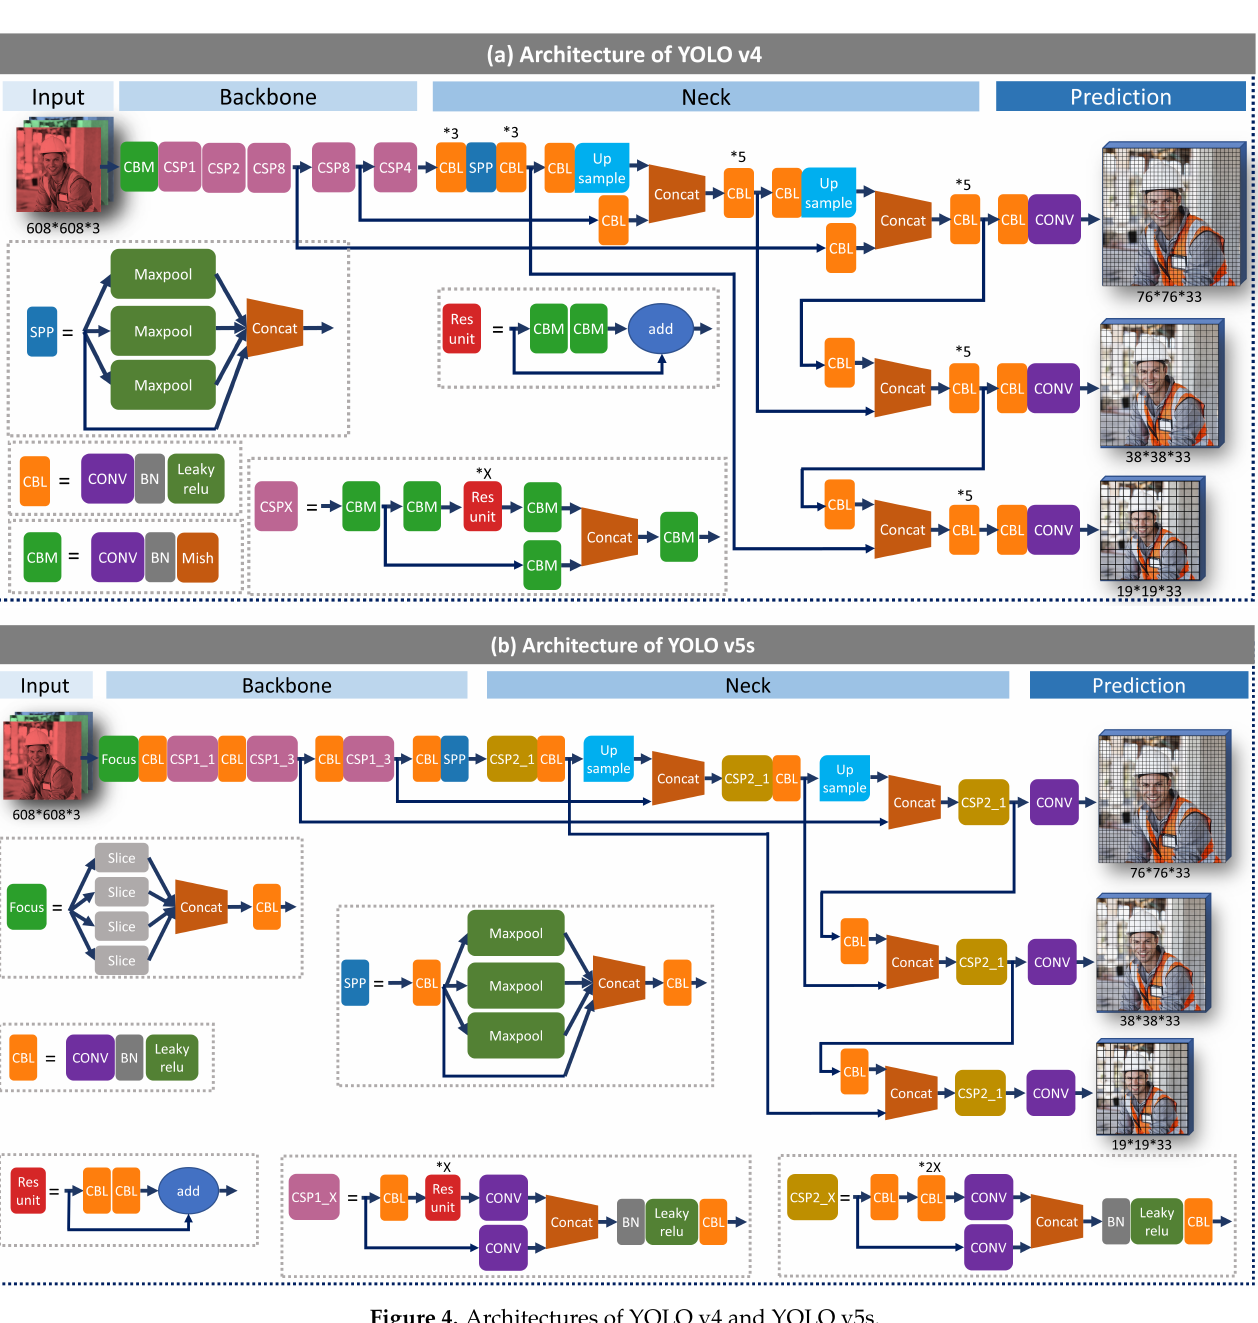
Figure 4. Architectures of YOLO v4 and YOLO